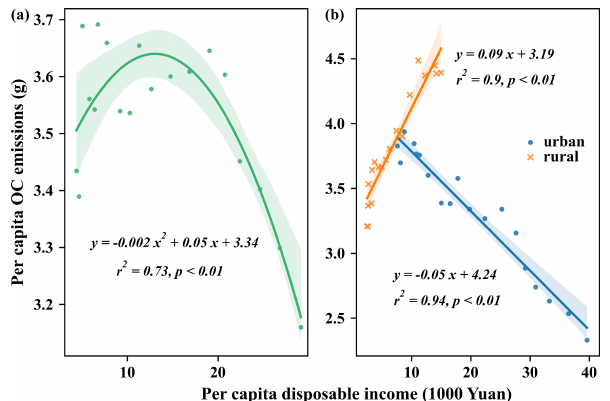
Figure 9. The relationship between the per capita disposable in- come and OC emissions from FMSs in China for the years from 2000 to 2018. Panel (a) shows the inverted U-shaped relationship between the income and the national average emissions. Panel (b) shows the correlation between income and emissions in urban and rural regions. The shaded areas represent the 95% confidence inter- vals. Please note that “Yuan” in this figure refers to CNY.